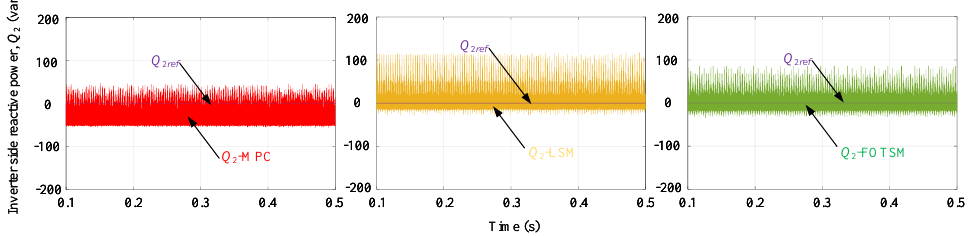
Figure 8. Theload grid reactive power responses under the MPC, the LSM and the FOTSM.